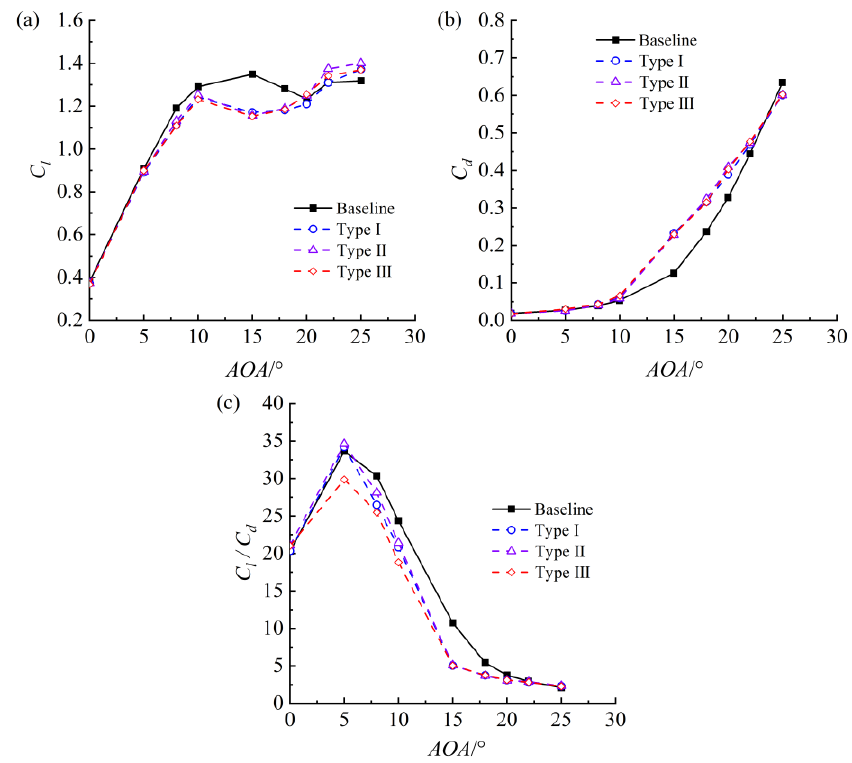
Figure 4. Numerical results for the four selected hydrofoils at different angles of attack ( AOA s): lift coefficient ( a ), drag coefficient ( b ), and C l / C d ratio ( c ).